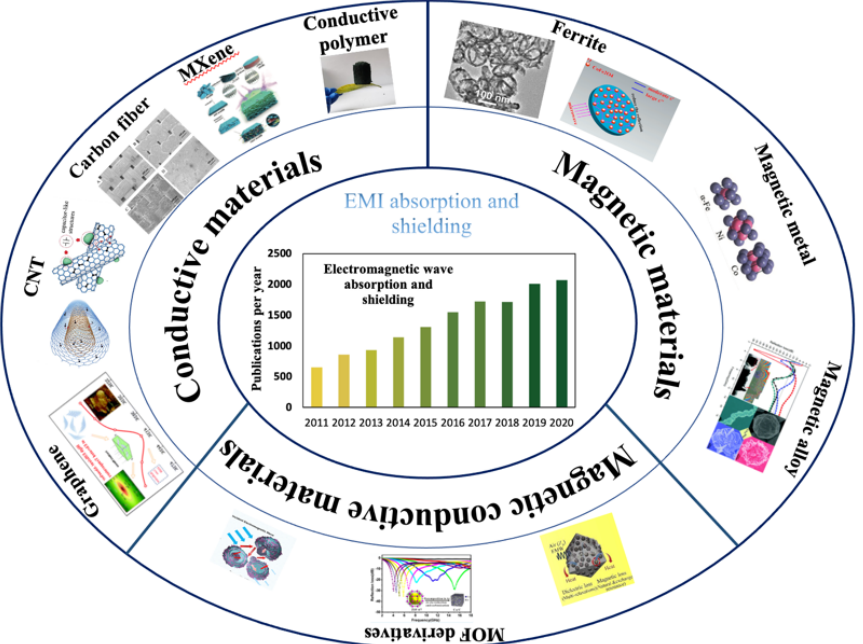
Figure 1. Materials applied in EMI absorption and shielding and the relevant publication numbers in the Web of Science.